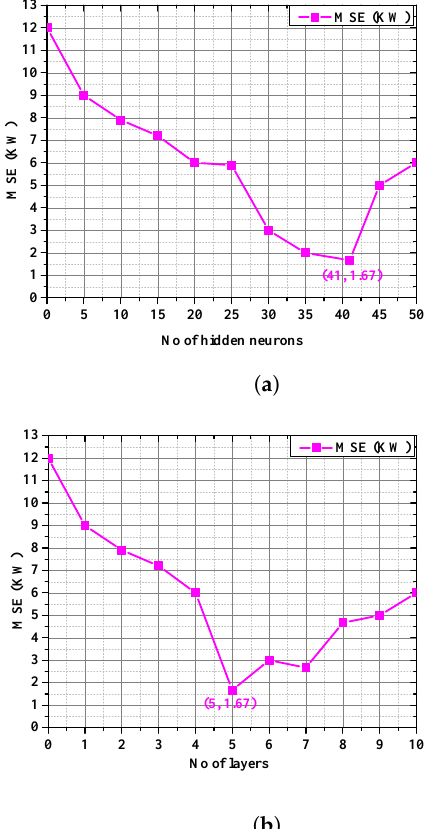
Figure 11. Demonstration of QLs validity with a various number of hidden neurons and layers. ( a ) Demonstration of QLs validity with various numbers of hidden neurons. ( b ) Demonstration of QLs validity with various numbers of hidden